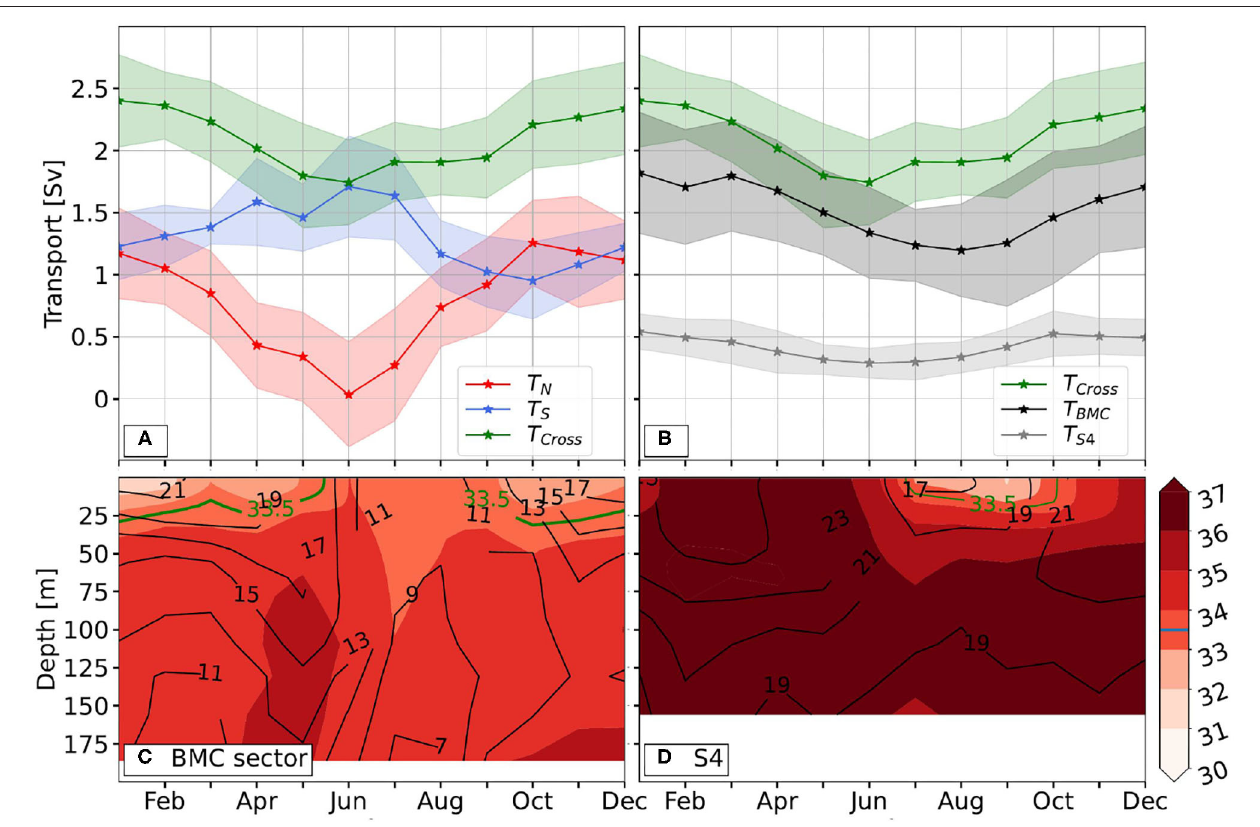
FIGURE 7 | (A,B) Record length monthly mean transports (Sv, solid line) and standard deviation (shading), through 30 ◦ S ( T N , red), 40 ◦ S ( T S , blue), the shelf break between 30 and 40 ◦ S ( T Cross , green), the BMC ( T BMC , black), and S4 ( T S 4 , gray) segments. (C,D) Vertical distribution of the annual cycle of temperature (black contours, with 2 ◦ C contour interval) and salinity (background colors, with 1 contour interval, 33.5 shown by green line) averaged over the shelf break BMC (C) and S4 (D) sectors.